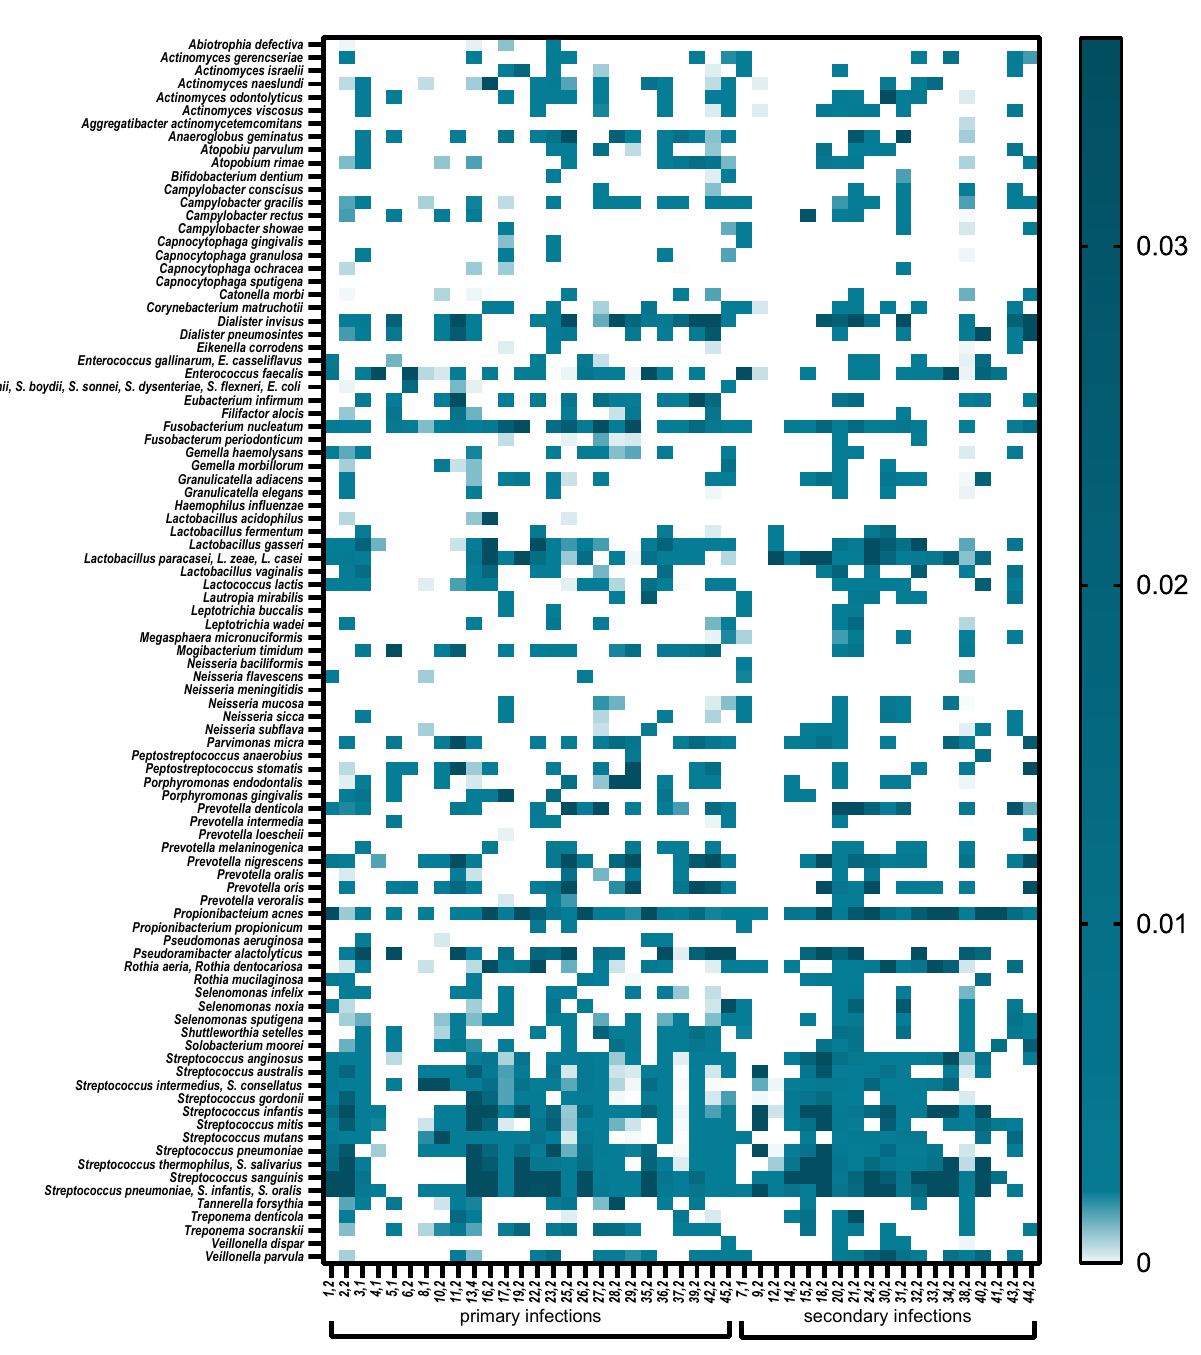
Figure 4. Heat map showing the relative abundance of species/genera genes across samples. Clinical parameters were correlated to relative species/genera abundance. It was shown that the higher values of DMFT were positively correlated with Actinomyces spp. (R = 0.30, p = 0.042), Lactobacillus spp. (R = 0.40, p = 0.006), Propionibacterium spp. (R = 0.34, p = 0.024) and Rothia spp. (R = 0.45, p = 0.002) and negatively with Escherichia/Shigella (R = − 0.38, p = 0.01). Approximal plaque index (API) was positively correlated to a higher abundance of Anaeroglobus geminatus (R = 0.32, p = 0.32), Mogibacterium timidum (R = 0.41, p = 0.005) and Porphyromonas spp. (R = 0.32, p =